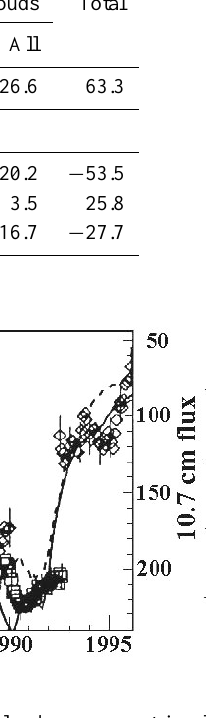
Fig. 2. Changes in the Earth’s cloud coverage: triangles – from satellite Nimbus 7); squares – from the International Satellite Cloud Climatology Project); diamonds – from the Defense Meteoroloical Satellite Program). Solid curve – CR intensity variation according to Climax neutron monitor, normalized to May 1965. Broken curve – solar radio flux at 10.7cm. All data are smoothed using twelve months running mean. According to Svensmark